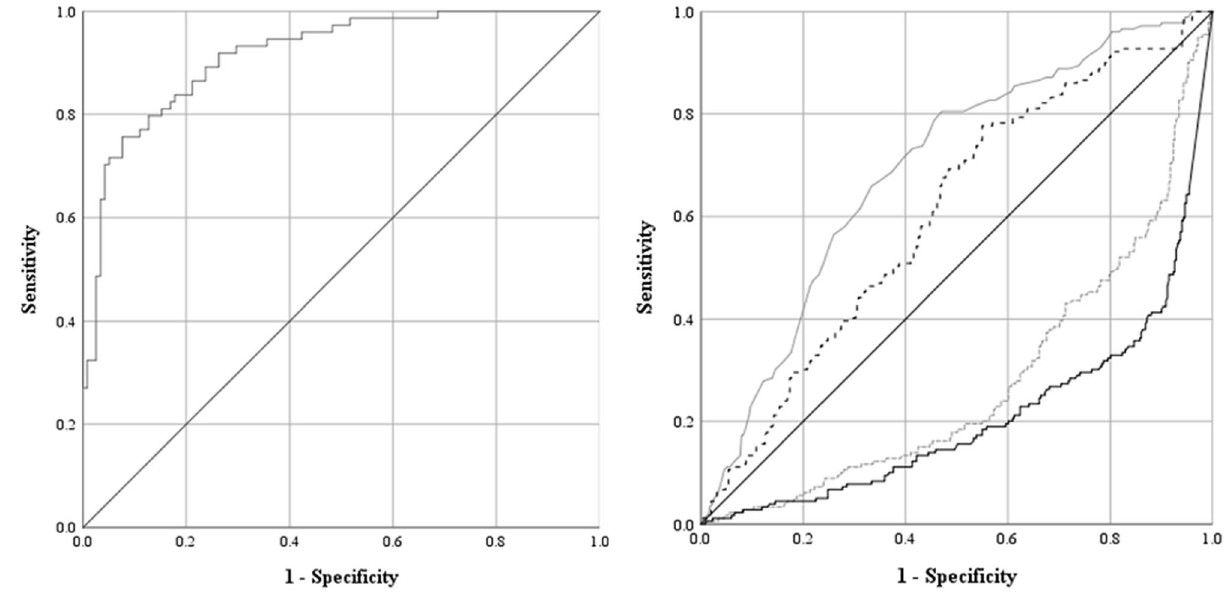
Figure 1. Receiver operating characteristic (ROC) curve of ( A ) the model showing an area under the ROC curve (AUC) of 0.915 (95% confidence intervals (CI), 0.876–0.955) and ( B ) the combined blood parameters leucocytes (doted grey line; AUC = 0.278, 95%CI, 0.232–0.324), eosinophils (straight black line; AUC = 0.208, 95%CI, 0.165–0.250), hemoglobin (straight grey line; AUC = 0.693, 95%CI, 0.646–0.739), and CRP (doted black